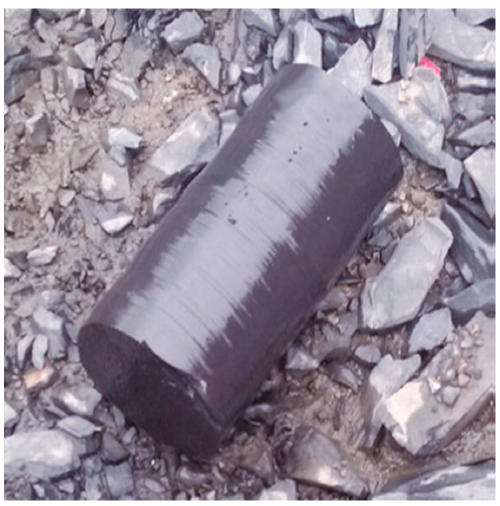
Figure 6. Shale core from Jiaoshiba, Chongqing City.